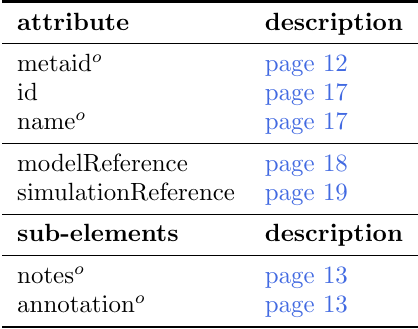
Table 2.19: Attributes and nested elements for task. o denotes optional elements and